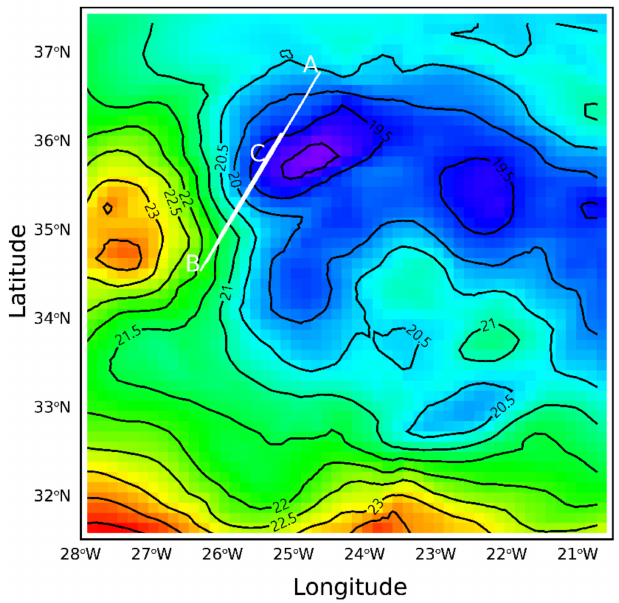
Figure 4. Sea surface temperature (SST) (isolines) at 12:00 UTC from ARPEGE with the aircraft track (thin black lines) on November 11. The reference points are denoted by A, B, and